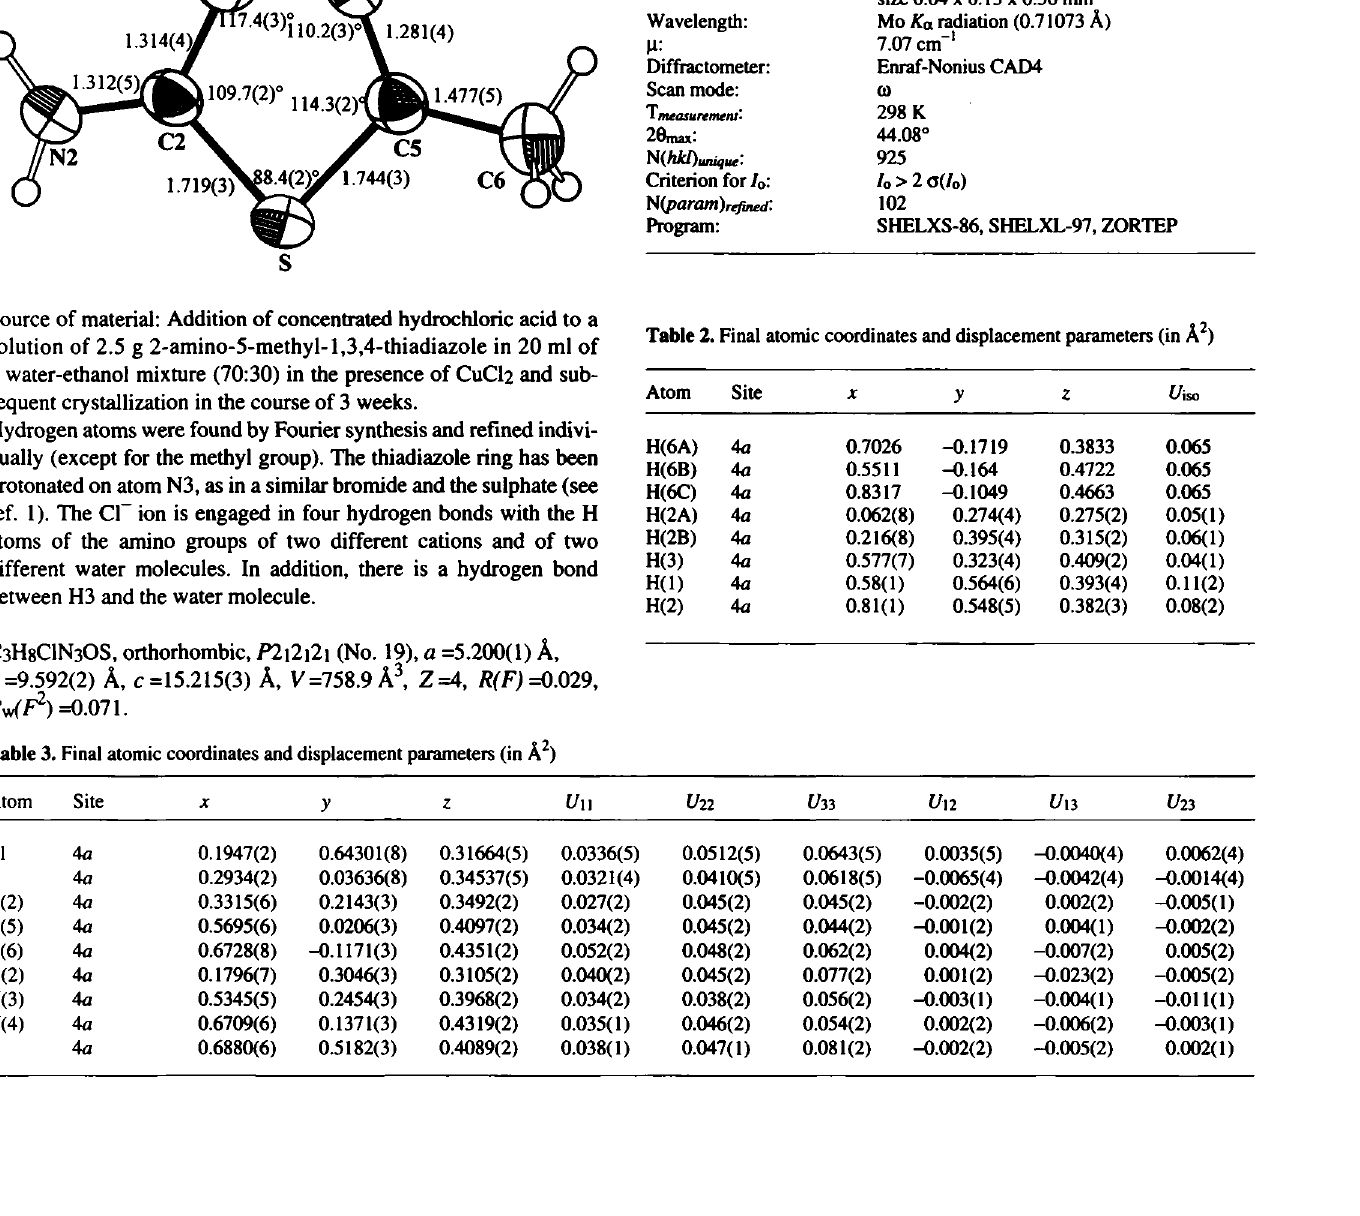
Table 1. Parameters used for the X-ray data collection Crystal: